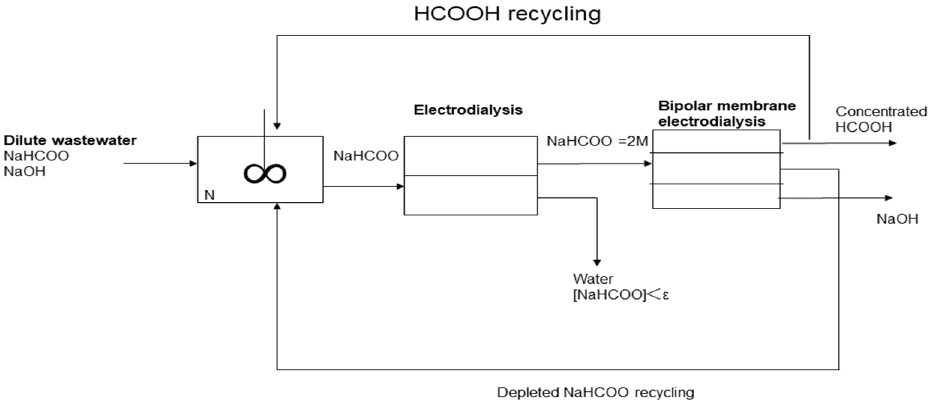
Figure 9. Global process for sodium formate splitting into formic acid and sodium hydroxide [74].